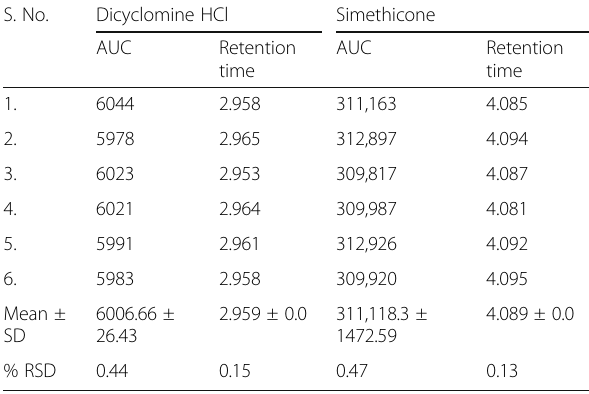
Table 5 Method precision study for Dicyclomine HCl and Simethicone sample solutions